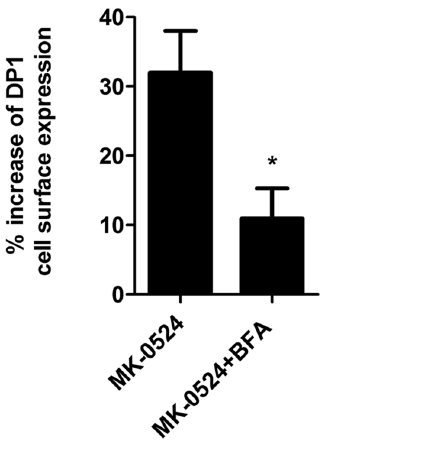
Figure 8. The promotion of DP1 cell surface targeting by MK- 0524 is inhibited by Brefeldin A. Cell surface receptor expression was measured by ELISA as described under ‘‘Materials and Methods’’ in HEK293 cells transiently expressing Flag-DP1 that were pre-incubated with vehicle or 20 m M of Brefeldin A (BFA) for 30 min, and then treated with 1 m M of MK-0524 or its control vehicle for 90 min. The results are shown as the percentage increase of DP1 cell surface expression when compared to control cells treated with vehicle. Results are the mean 6 S.E. of three independent experiments. * is P , 0.05.